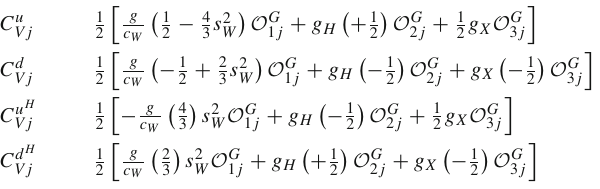
Table 5 Coupling coefficients C f